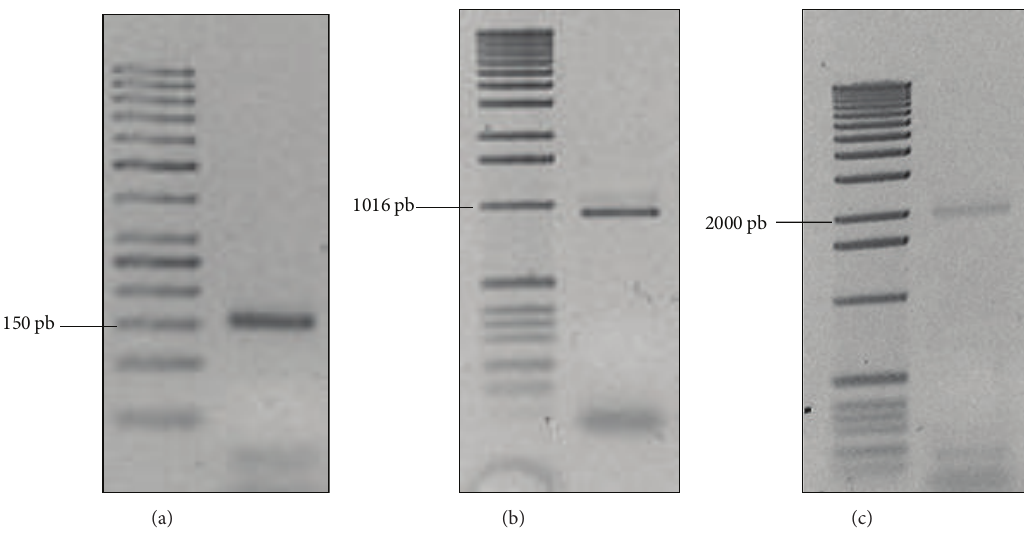
Figure 4: CODEHOP-based PCR for the amplification of the putative genes copA and copM from S. metallicus . Amplification products, (a) using degenerate PCR primers (DOP) copM degF and copM degR designed from amino acid sequence conserved blocks of Sulfolobales CopM proteins, (b) using primers copA cdegF and copA cdegR designed by CODEHOP strategy for amplification of a copA -like gene. (c) PrimerscopM degFandcopA cdegRwereassesedfortheamplificationofa copMA -likeDNAregion.Thoseprimersweretestedwithgenomic S. metallicus DNA samples. Amplicons expected sizes were as follows: ca. 150bp for copM, ca. 950 bp for copA , and ca. 2,000 bp for copMA . PCR products were excised and cloned for later